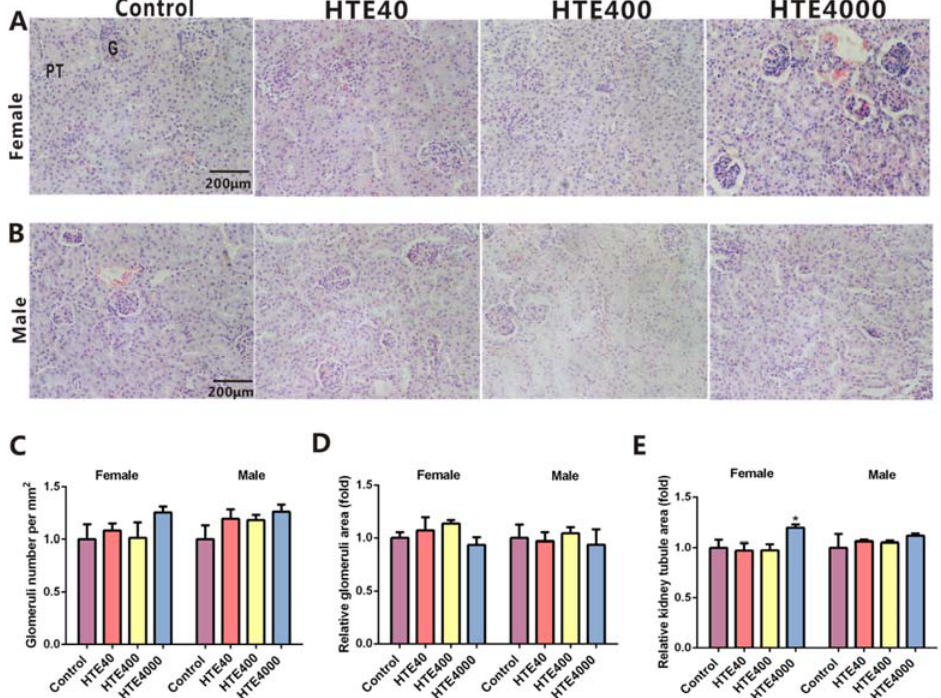
Figure 3. The histopathological examination of the kidneys in the HTE (40, 400 and 4000 mg/kg) subacute administration study. All data are presented as the mean ± SEM ( n = 3). ( A ) Image of renal sections stained with HE for females. Scale bar = 200 µ m. G and PT represents glomeruli and proximal tubule, respectively. ( B ) Image of renal sections stained with HE for males. ( C ) The number of glomeruli for females and males. ( D ) Relative area of kidney tubule for females and males. ( E ) Relative area of glomeruli for females and males. Statistical significance was analyzed by using the Student’s t -test. Compared with the control, * represents 0.01 < p < 0.05.